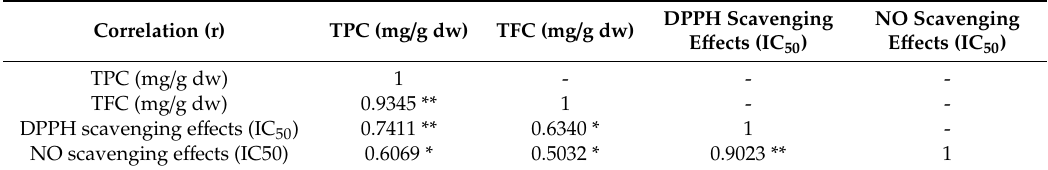
Table 5. Correlation of antioxidant activity and phenolic compounds of 50% ethanol extracts of leaves, seeds, and roots from C. cajan.